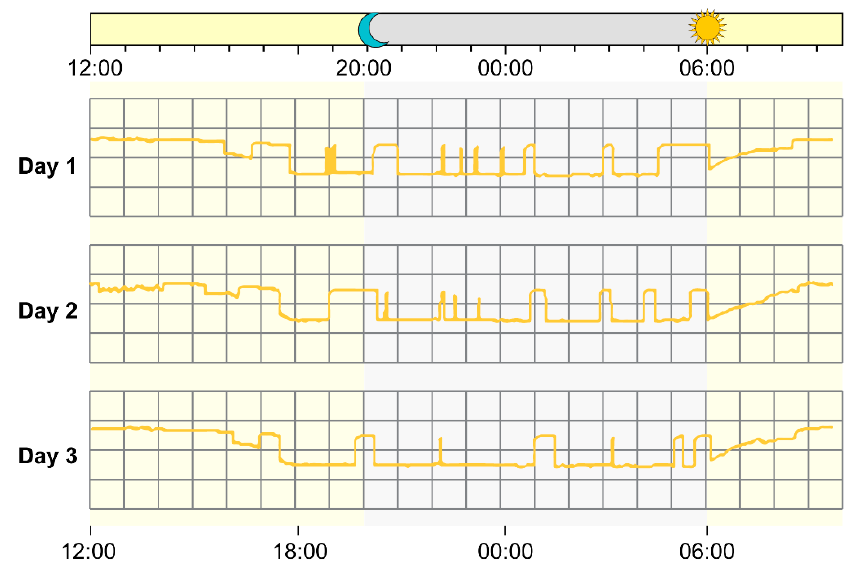
Figure 1. Light pattern in the intensive care unit.